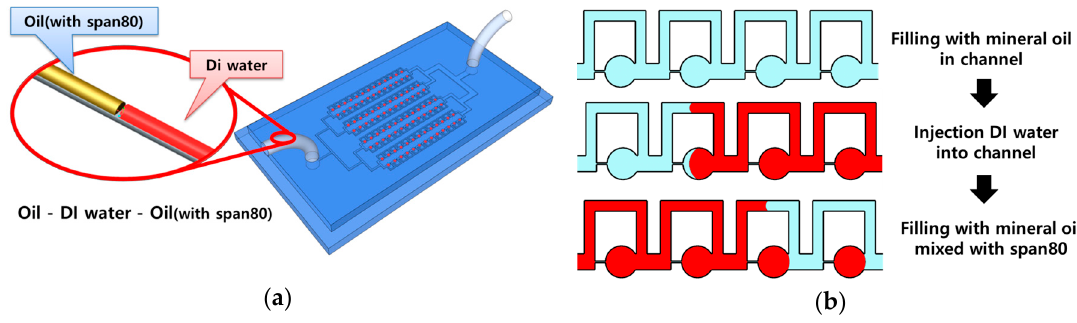
Figure 1. Schematic ( a ) and sample array process ( b ) of parallel microfluidic